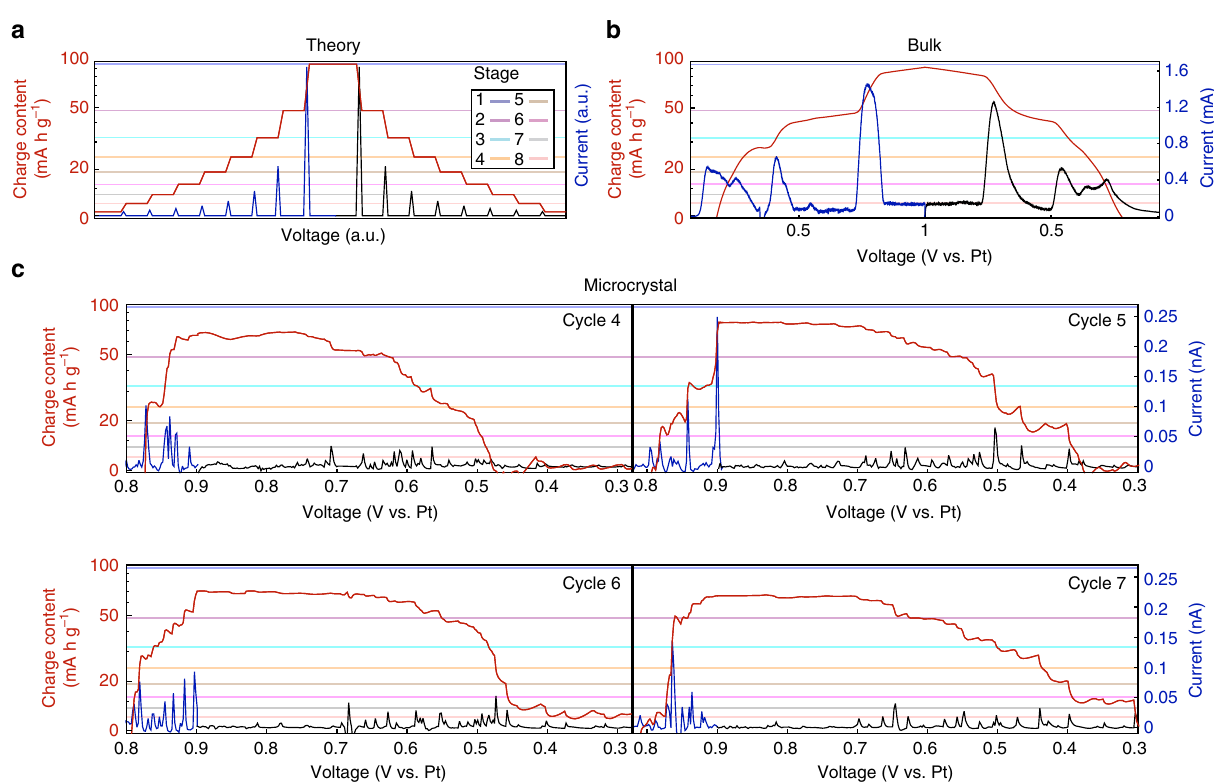
Fig. 7 Current and charge content vs. voltage for the intercalation/deintercalation of graphite. The blue (black) curves represent positive (negative) current. The red curves give the charge content, calculated by integrating the current. Current is plotted on a linear scale and charge content on a logarithmic scale (to better separate high stage numbers). The speci fi c capacities corresponding to stages 1 – 8 are indicated by the colored lines. a Model intercalation/deintercalation cycle 14 consistent with the RH and DH theories. b Intercalation/deintercalation cycle of bulk graphite (see Supplementary Fig. 2). c Four consecutive intercalation/deintercalation cycles from a single graphite microcrystal. The background current has been subtracted (for the raw CVs and sequential cycles see Supplementary Figs 7 and 8,